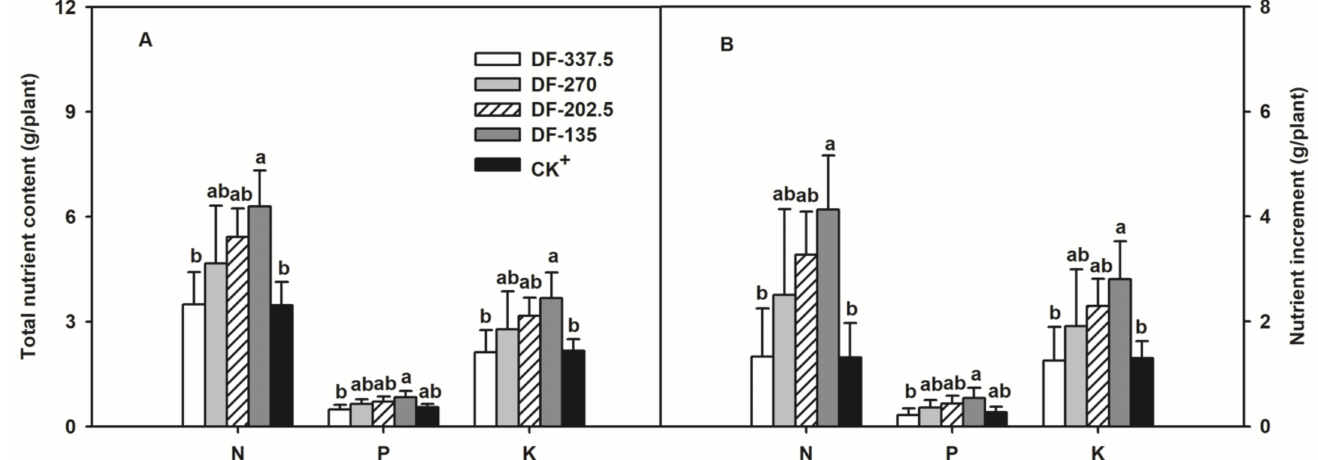
Figure 4. NPK absorptions in citrus plant under fertigation levels. (A) Total nutrient content and ( B ) nutrient increment in different fertigation levels. The data are presented as mean ± SD n = 3. Different letters between treatments indicate significant differences at p < 0.05. NPK incre- ment = NPK contents of plants after test − NPK contents of plants before